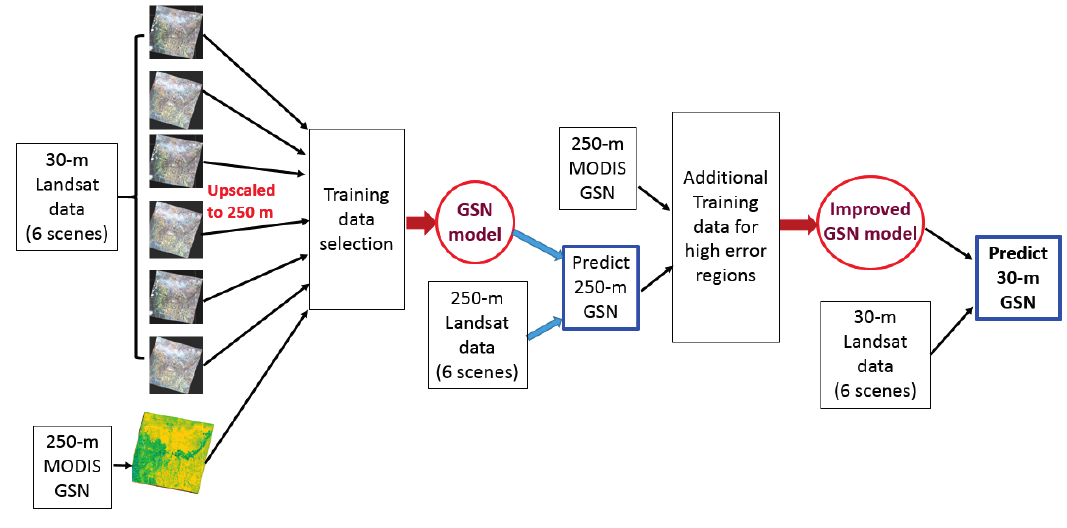
Figure 2. Flowchart for developing the 30-m MODIS-Landsat based GSN